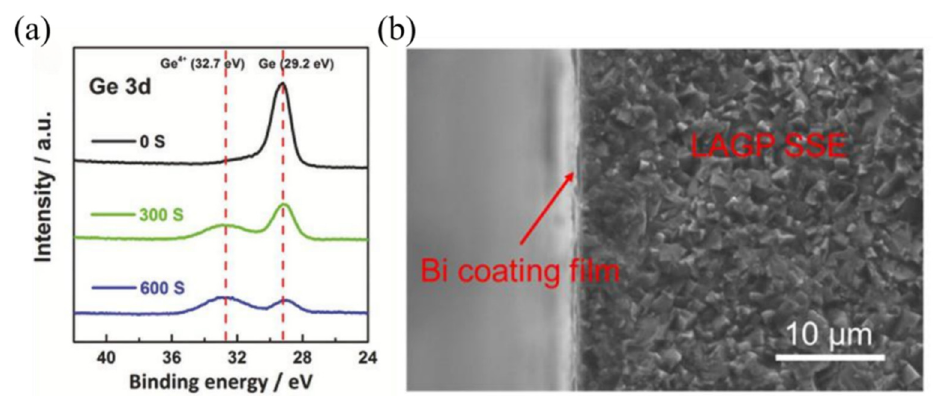
Figure 9. ( a ) XPS of the Ge film on LAGP pellet. Reprinted with permission from ref. [136]. Copyright 2018 WILEY-VCH Verlag GmbH & Co. KGaA, Weinheim. ( b ) Cross-sectional SEM image of the LAGP pellet coated with Bi buffer. Reprinted with permission from ref. [137]. Copyright 2020 American Chemical Society.